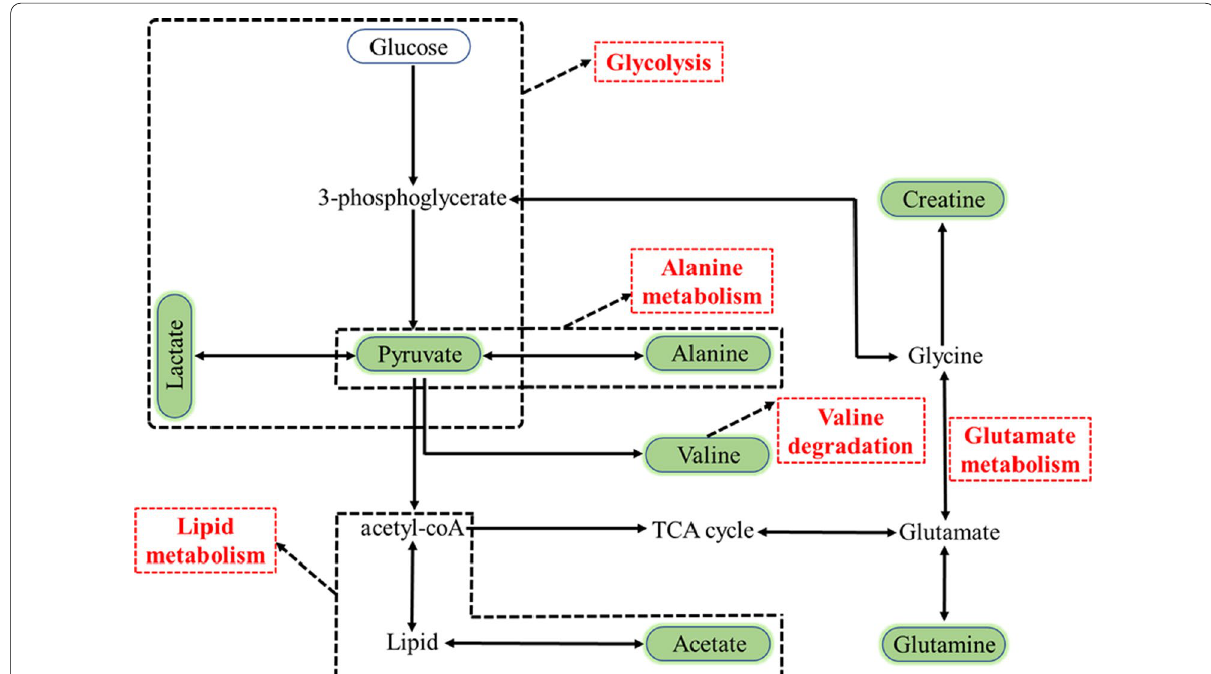
Fig. 2 The schematic metabolic pathways of hepatocarcinogenesis during diabetic conditions obtained from the KEGG and HMDB databases. The dynamic changes of the metabolites (denoted in the green boxes) detected by 1 H-NMR serum analysis display the link with the metabolic pathways (represented in the red dotted boxes). KEGG, Kyoto Encyclopedia of Genes and Genomes (https:// www. genome. jp/ kegg/ pathw ay. html); HMDB, Human Metabolome Database (https:// hmdb. ca/ metab